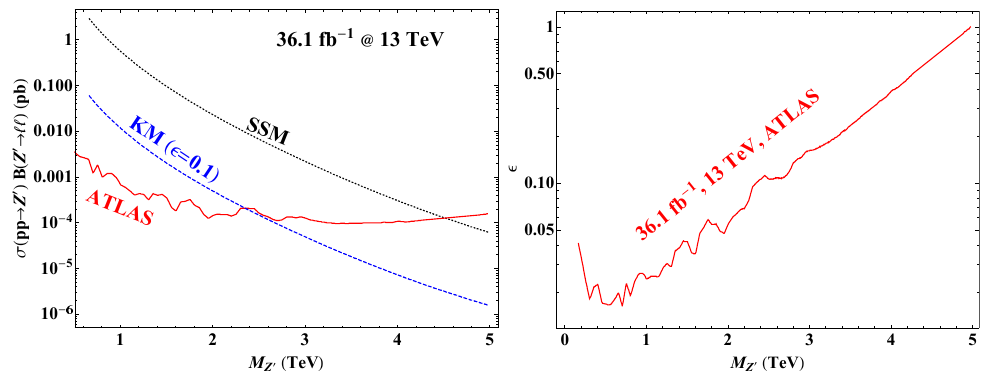
Figure 13 . Left panel: ATLAS constraints (13 TeV and 36.1 fb (cid:0) 1 ) [64] on the Z 0 boson in the dilepton channel. Overlaid are the predictions in the kinetic mixing (KM) model with parameter (cid:15) = 0 : 1 and in sequential SM (SSM) model. Right panel: ATLAS upper bound on (cid:15) in the KM model as a function of the Z 0 mass.